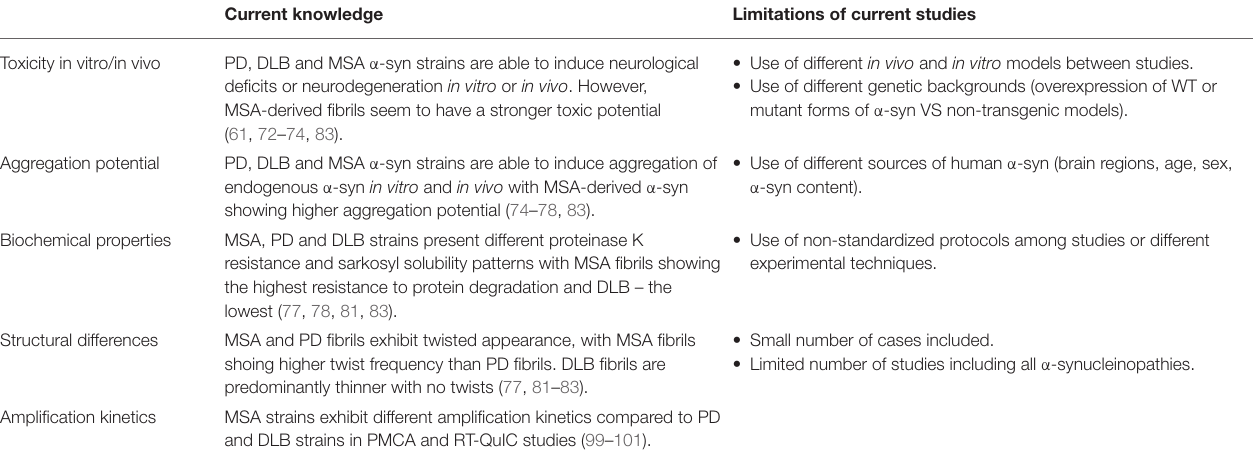
TABLE 1 | Evidences supporting the existence of distinct strains in classical α -synucleinopathies and limitations of the current